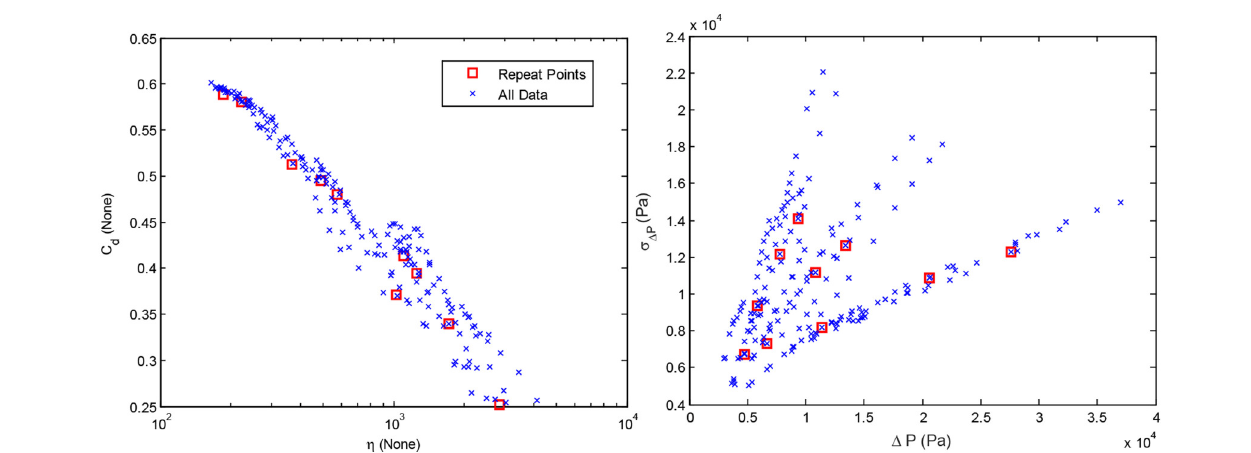
FIGURE 9 | The repeat points chosen for uncertainty analysis overlaid over the 189 data points. They were chosen to span the range of C d values, yet represent the lower range of the 1 p measurement, where uncertainty is higher. Note that the relationship between C d and η appears linear on a logarithmic x-axis, as opposed to the non-linear relationship shown in Figure 5A .